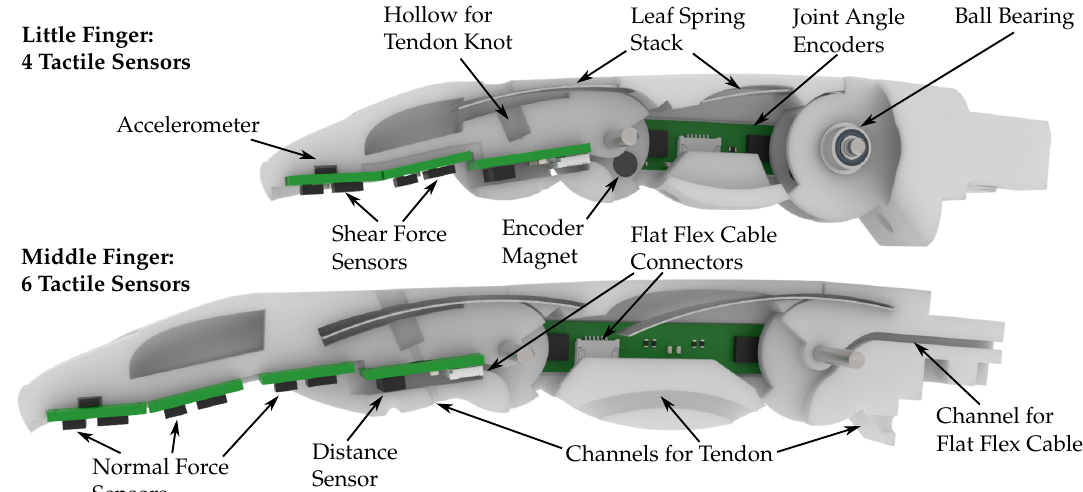
Figure 3. Section view of the little and middle finger with the model scaled to the 50 th percentile female dimensions. The section view of the little finger shows the joints of the finger while the deeper cut into the middle finger shows the paths for both the flat flex cables (FFCs) and the tendon.